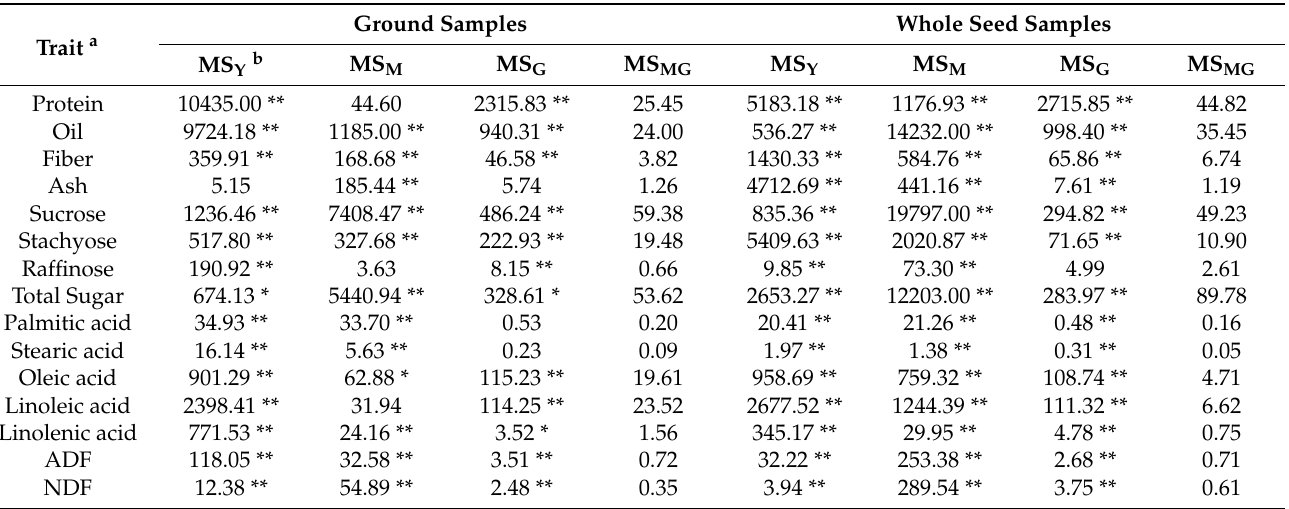
Table 4. Mean squares from ANOVA of seed composition traits in edamame with ground and whole seed samples by combined data of freeze, low-heat and high-heat drying methods.